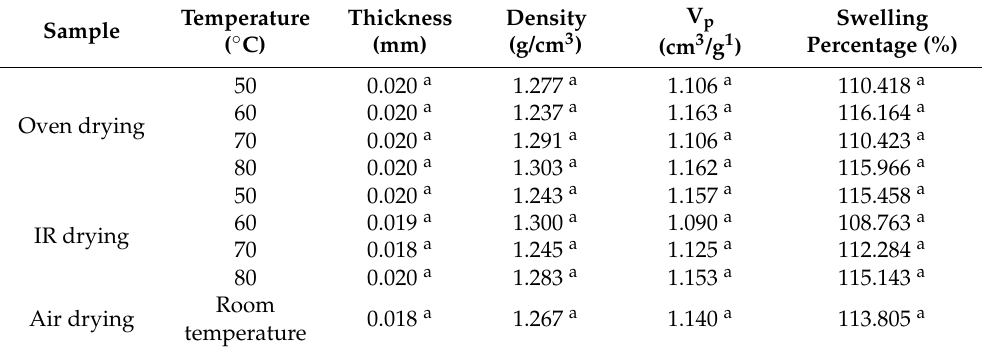
Table 4. Thickness, density, pore volume, and swelling percentage for dried RCF.